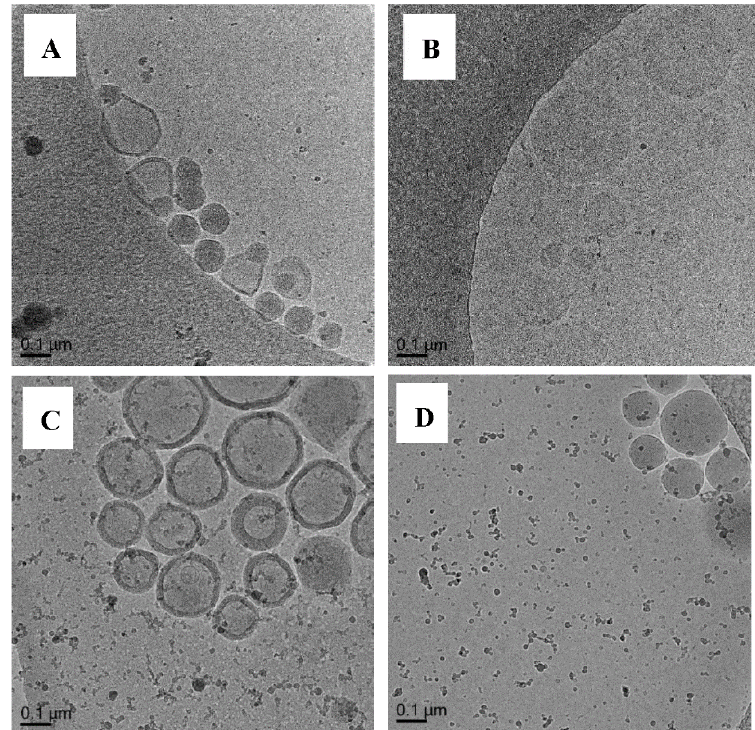
Figure 15. Cryo-TEM micrograph of Exp 16 ( A ), polymerization of (DODAB- Oligo 2A ) with MMA; Exp 17 ( B ), polymerization of (DODAB- Oligo 2A ) with MA; Exp 18 ( C ), polymerization of (DODAB- Oligo 2A) with MA/EGDA and Exp 19 ( D ), polymerization of (DODAB -Oligo 2A ) with BA/EGDA. Additional images in Figure S11 (Exp 17) and Figure S12 (Exp 18).